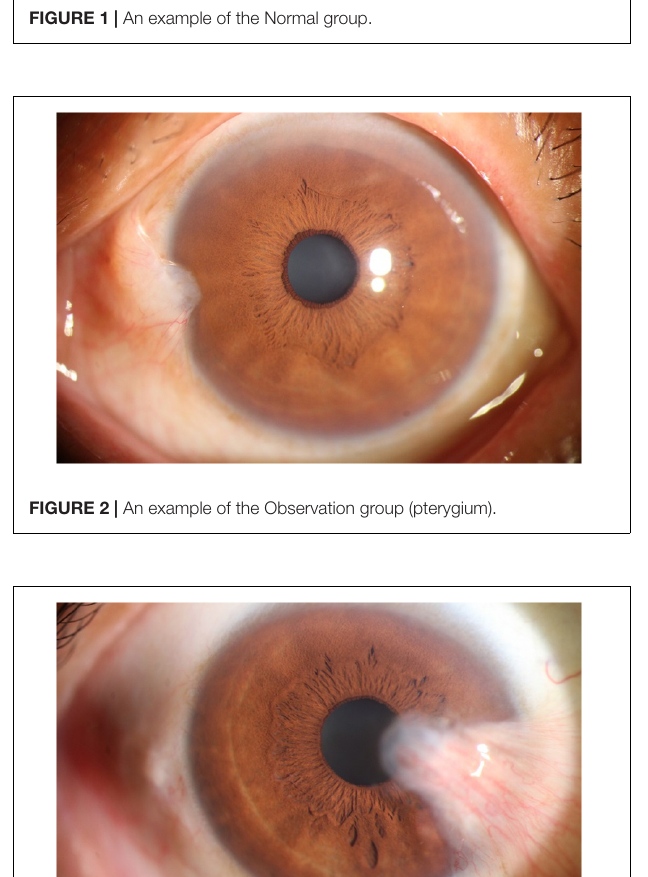
(ii) the observation group (pterygium) with the proliferative head extending beyond the corneal limbus < 3 mm by horizontal length (as shown in Figure 2 ); and (iii) the operation group (pterygium) with the head extending beyond the limbus ≥ 3 mm by horizontal length (as shown in Figure 3